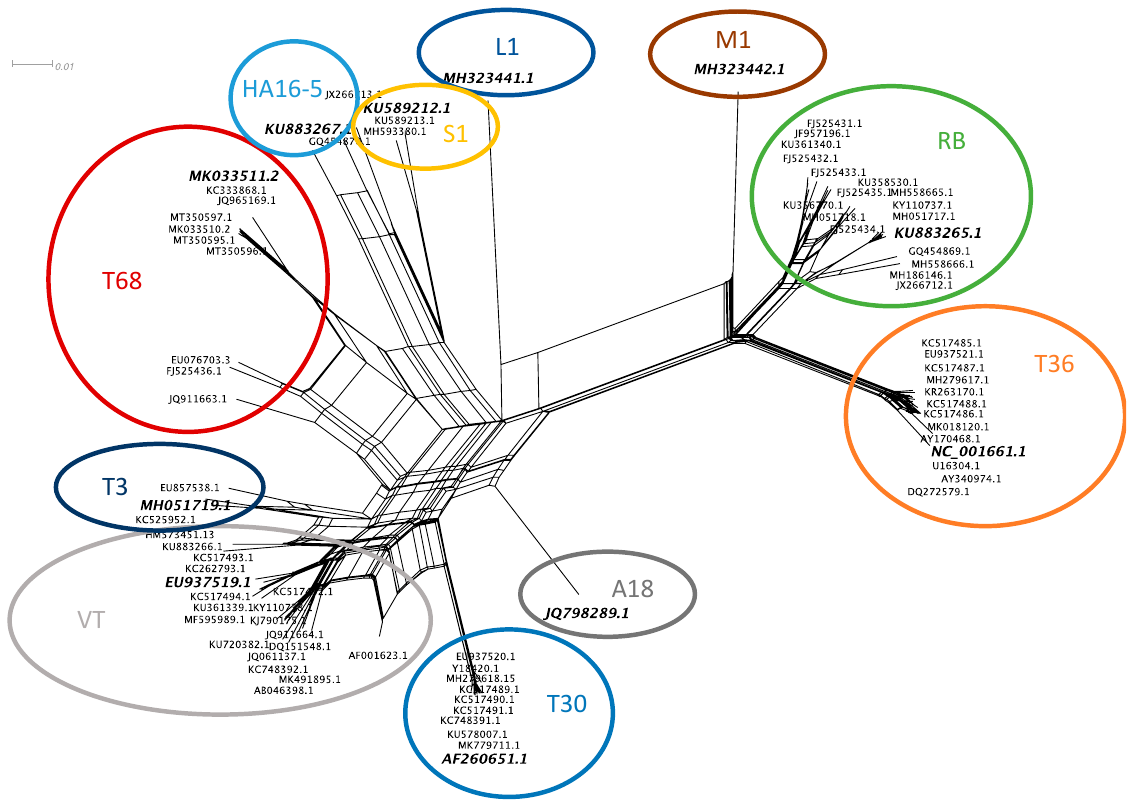
Figure 1. Neighbor network reconstruction of the complete genomes of citrus tristeza virus (CTV). Genotype groups are indicated with colored circles, and a representative accession from each group is highlighted with increased font size and italics.